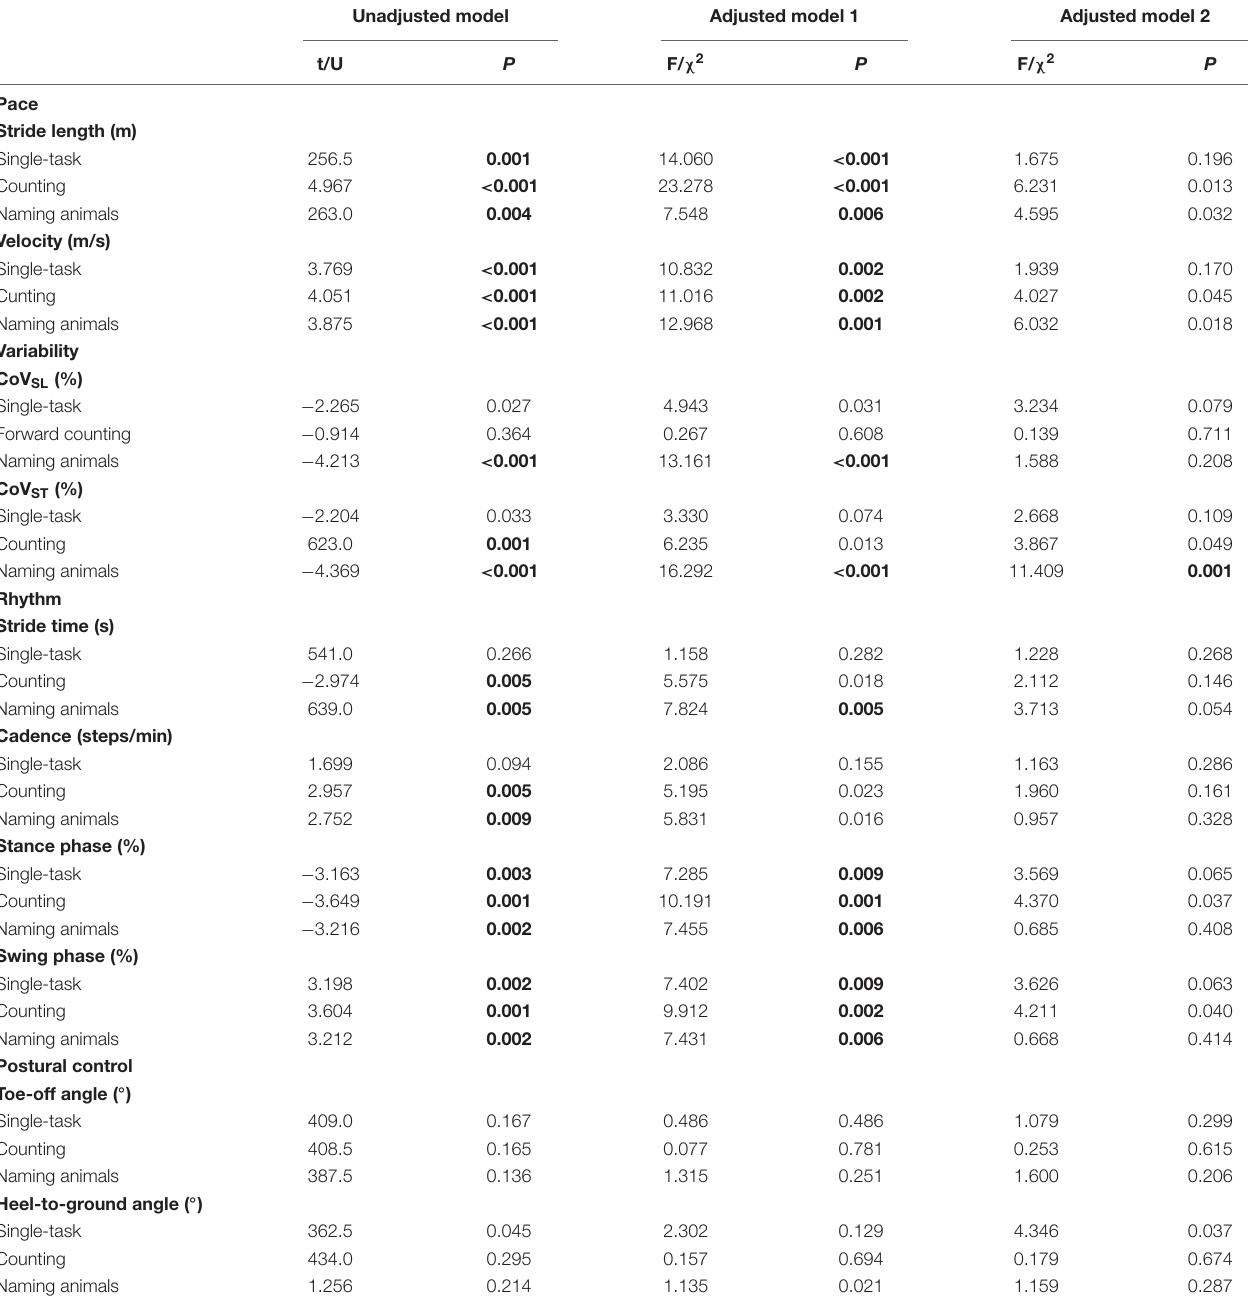
TABLE 3 | Comparison of gait characteristics of individuals with post-stroke dementia (PSD) and individuals with post-stroke non-dementia